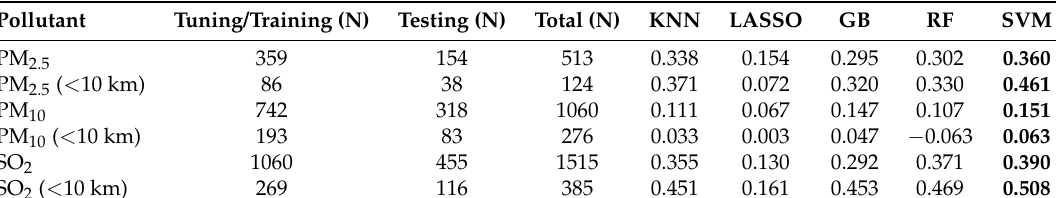
Table 3. Sample sizes of spatiotemporally matched MISR mixtures with median test R 2 for each machine learning method and pollutant. Largest R 2 for each pollutant is indicated in bold .